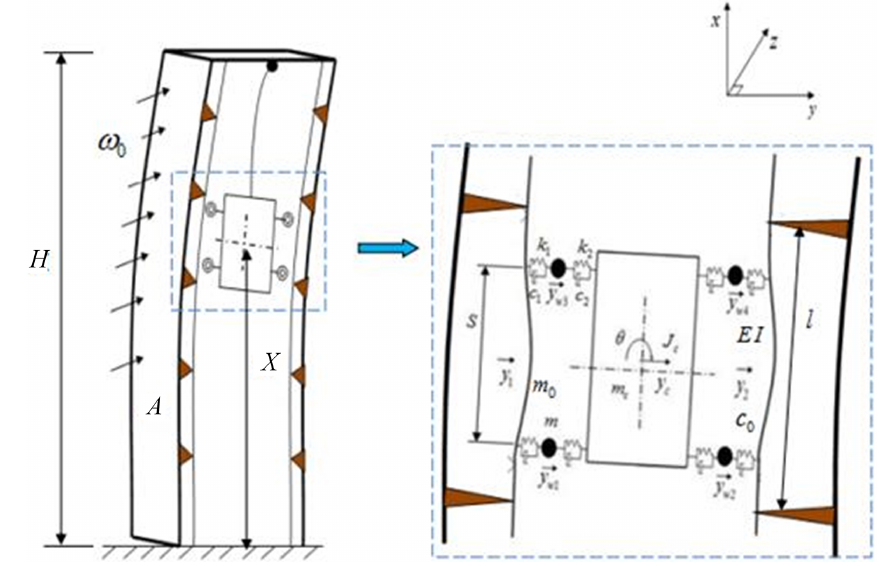
Figure 1. Horizontal vibration model of the guide rail, guide shoe, and car coupling